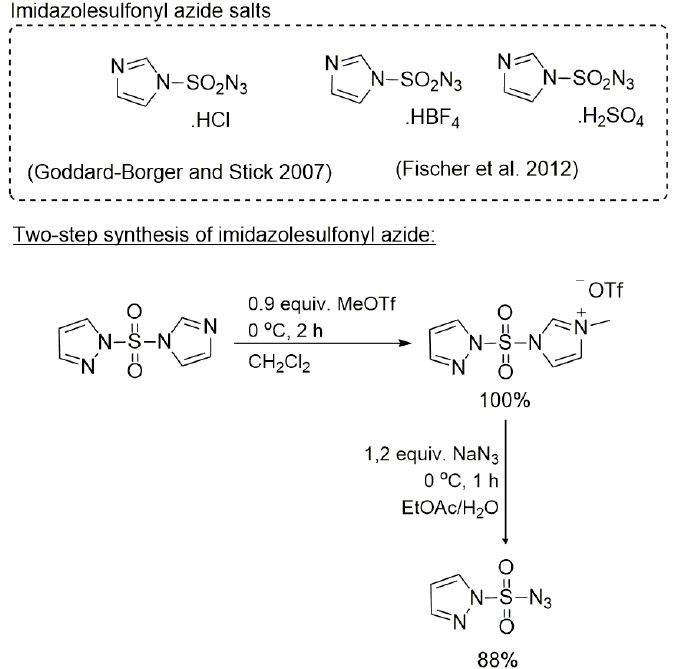
Figure 24 - Imidazolesulfonyl azides salts and two-step synthesis of free base imidazolesulfonyl azide.